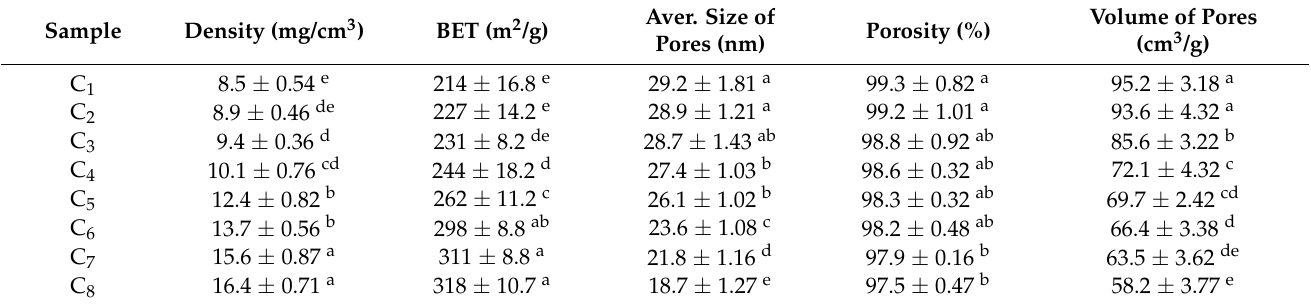
Table 2. BET surface area, size of pores and volume of pores CNC and TEPIC-CNC